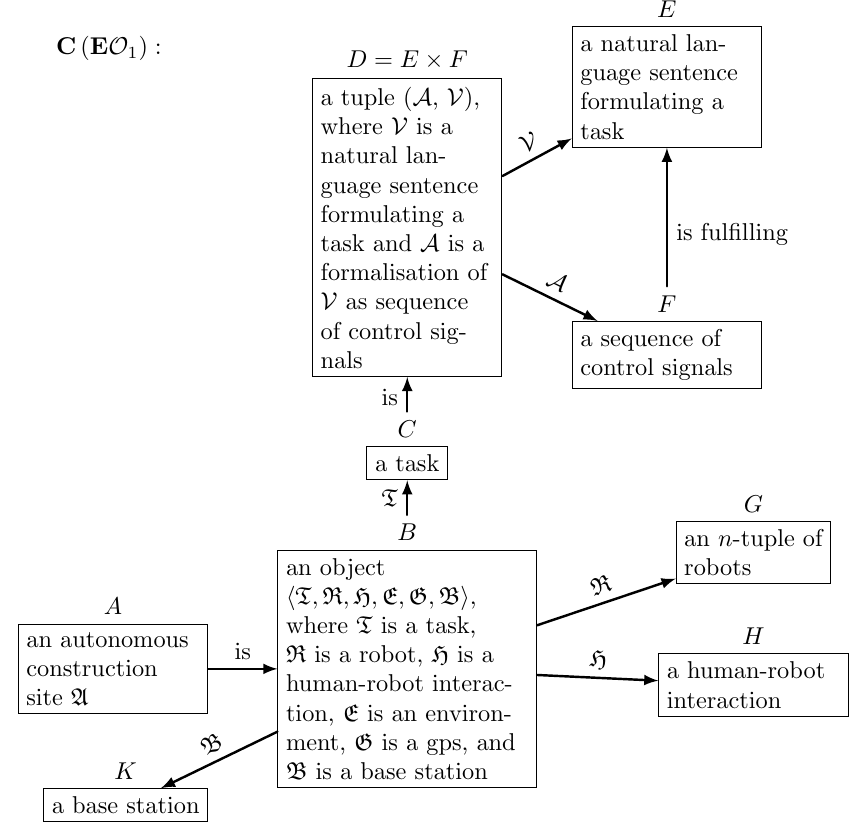
Figure 4. Olog representation of an autonomous construction site after the application of a contraction mapping C to the expanded olog E O 1